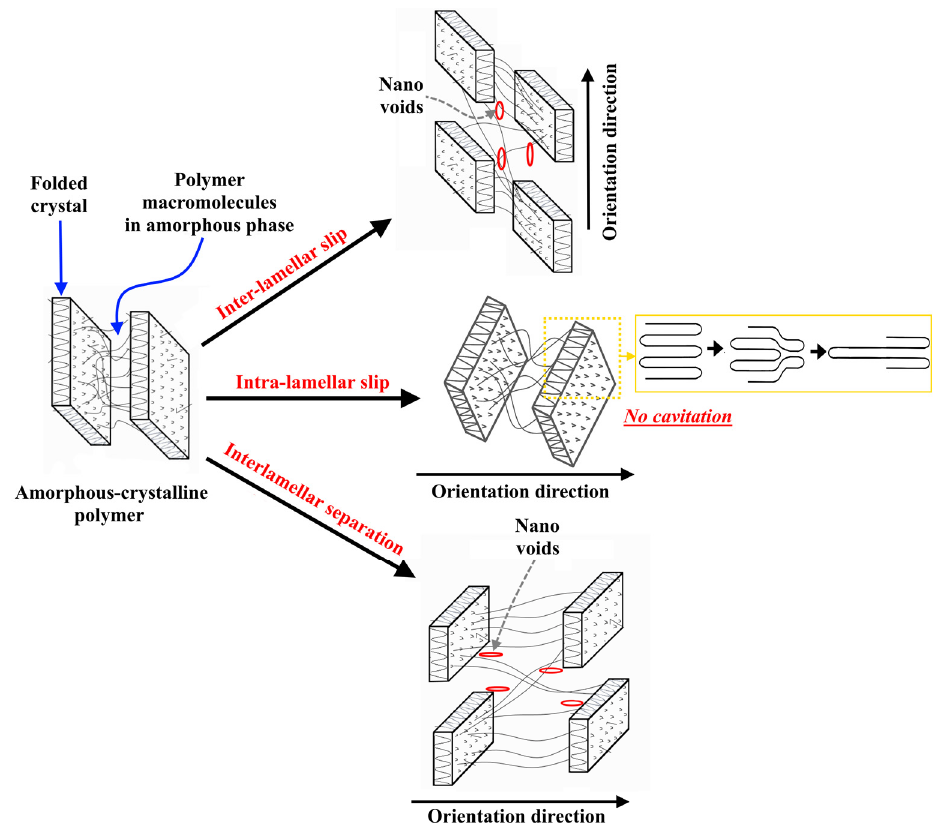
Figure 1. Deformation mechanisms of amorphous-crystalline polymer.